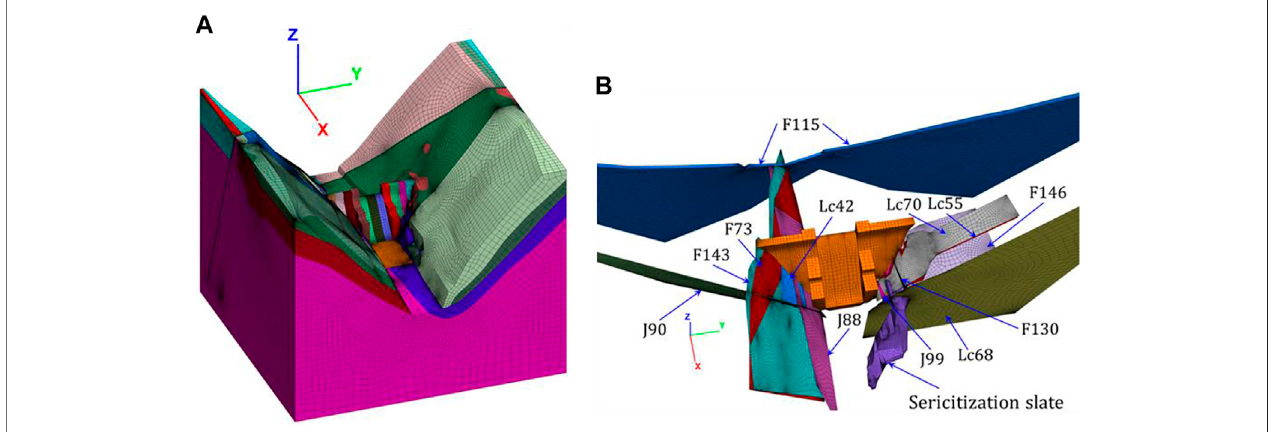
FIGURE 1 | (A) The whole numerical mesh model of the Kala hydropower station. (B) Spatial relationship between the Kala dam and the structural